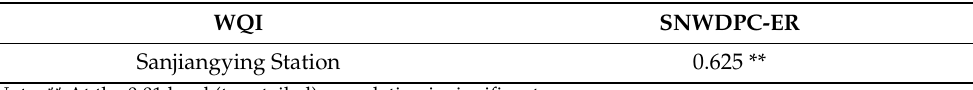
Figure 8. Comparison of the WQI of the SNWDPC-delivery ER’s canal and WQI of the Sanjiangying station on the Yangtze River during the water diversion periods in 2014–2018. Table 6. Correlation analysis between the WQI of the SNWDPC-delivery ER’s canal and the WQI of Sanjiangying station on the Yangtze River during the water diversion periods in 2014–2018. WQI SNWDPC-ER Sanjiangying Station 0.625